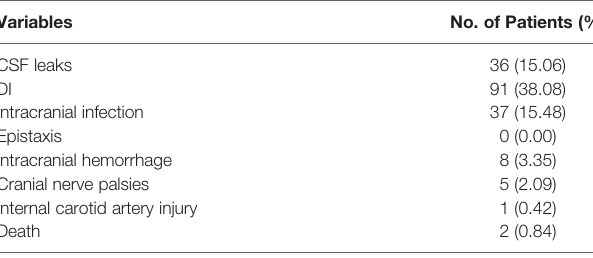
TABLE 5 | Surgical